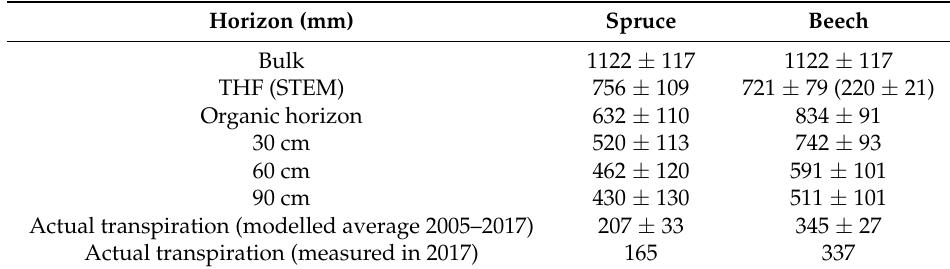
Table 2. Mean annual water percolating through particular layers of forest stands and actual transpiration. THF—throughfall, STEM—stemflow. Horizon (mm) Spruce Beech Bulk 1122 ±